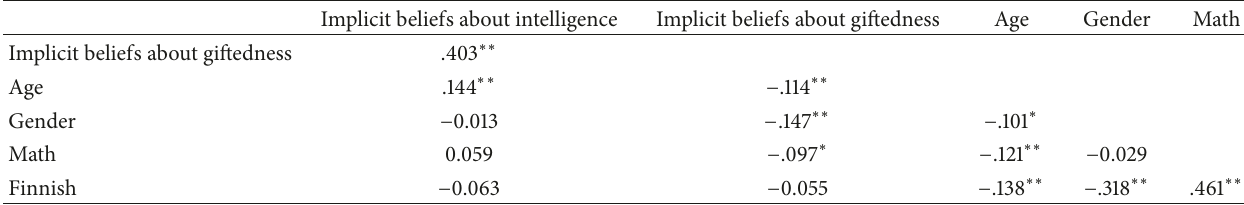
Table 4: Bivariate Pearson correlations.